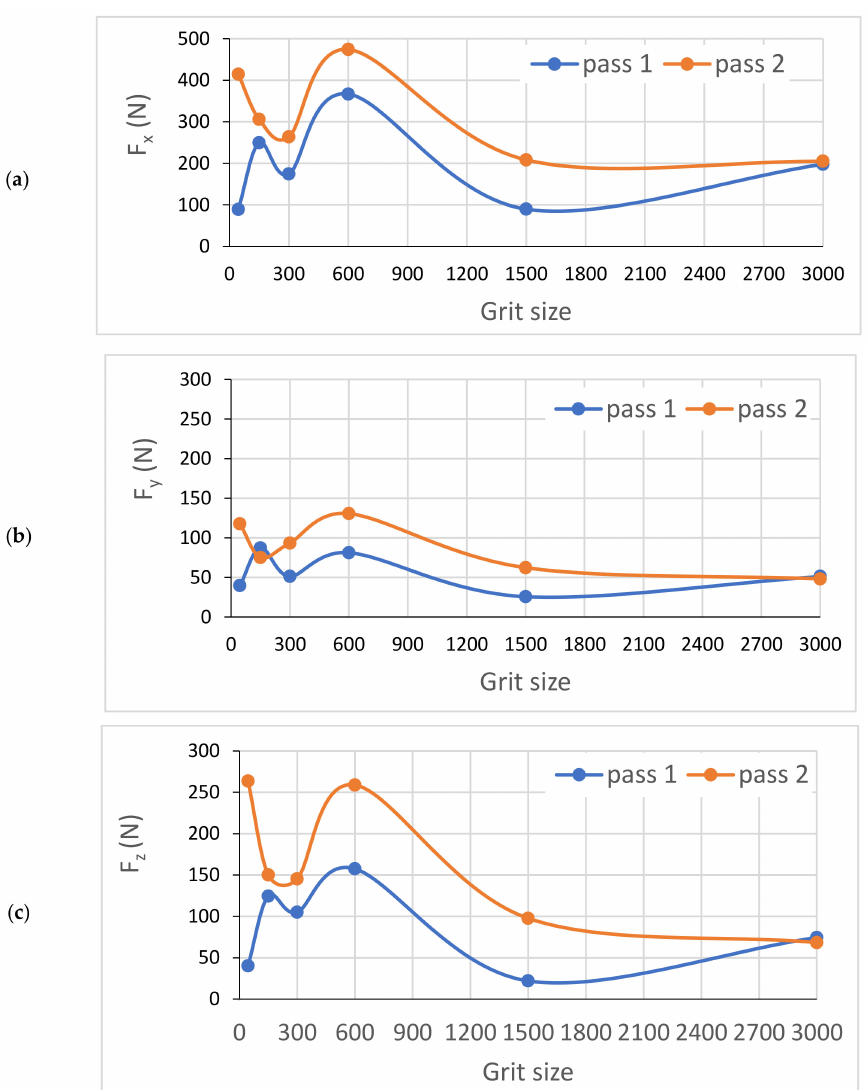
Figure 22. Variation of different forces while grinding white granite edge with two passes under the same conditions (Vs = 2500 rpm, f = 1000 mm/min): ( a ) Fx, ( b ) Fy, and ( c ) Fz. The arithmetic mean deviation of the roughness Ra was the criteria used for the comparative analysis of the surface profiles obtained after